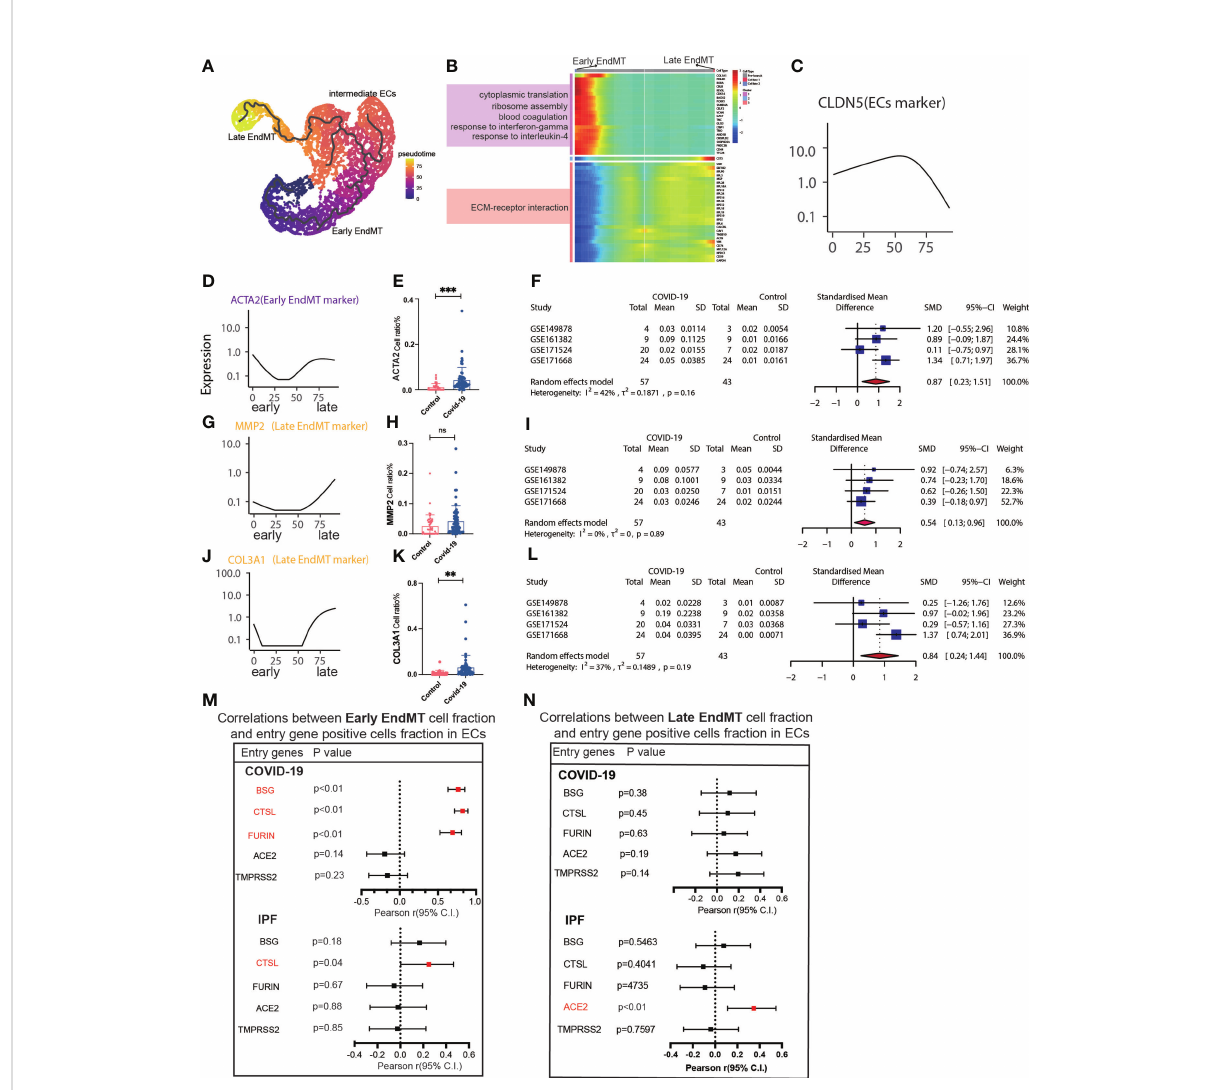
FIGURE 5 Characteristics of early and late stage EndMT. (A) Pseudotime projection analysis showing early-stage EndMT could evolve to late-stage EndMT. (B) Single cell proposed time branch point analysis showing genes with progressively lower and higher expression from Early EndMT to Late EndMT. Each row of the heat map on the right represents a gene, each column is a proposed time point, and the color represents the average expression value of the gene at the current time point, with the color decreasing from red to blue. The left side shows the signaling pathways that the gene set is enriched to. (C) The proposed time trajectory of a single gene, showing the change in gene expression of the ECs marker gene (CLDN5) from the beginning to the end of the proposed time course. (D) Trajectories of individual genes, showing changes in gene expression of Early EndMT marker genes (ACTA2) from the beginning to the end of the proposed time course. (E) ACTA2 gene positive ECs ratio is higher in COVID-19 than that in HC. (F) Forest plot of studies with ACTA2 gene positive ECs ratio on the COVID-19 and HC, after excluding a study with only one case. The analysis included data from 4 studies with a total of 57 COVID-19 and 43 controls. p value for heterogeneity was 0.16, I2 was 42%. (G) Temporal trajectories of individual genes showing changes in gene expression of Late EndMT marker gene (MMP2) from the beginning to the end of the proposed time course. (H) MMP2 gene positive ECs ratio is higher in COVID-19 than that in HC. (I) Forest plot of studies with MMP2 gene positive ECs ratio on the COVID-19 and HC, after excluding a study with only one case. The analysis included data from 4 studies with a total of 57 COVID-19 and 43 controls. p value for heterogeneity was 0.89, I2 was 0%. (J) Trajectories of individual genes showing changes in gene expression of the Late EndMT marker gene (COL3A1) from the beginning to the end of the proposed time course. (K) COL3A1 gene positive ECs ratio is higher in COVID-19 than that in HC. (L) Forest plot of studies with COL3A1 gene positive ECs ratio on the COVID-19 and HC, after excluding a study with only one case. The analysis included data from 4 studies with a total of 57 COVID-19 and 43 controls. p value for heterogeneity was 0.19, I 2 was 37%. (M) Forest plot showing the correlation between Early EndMT cell fraction and entry gene positive cells fraction in ECs. Entry factors (BSG, FURIN, CTSL) was positively correlated with the expression of Early EndMT in COVID-19 (p < 0.05, Pearson ’ s r > 0). CTSL was positively correlated with the expression of Early EndMT in IPF (p < 0.05, Pearson ’ s r > 0). (N) Forest plot showing the correlation between Late EndMT cell fraction and entry gene positive cells fraction in ECs. Entry factors (ACE2) was positively correlated with the expression of Late EndMT in COVID-19 (p < 0.05, Pearson ’ s r > 0). **P < 0.01, ***P < 0.001; NS, P >